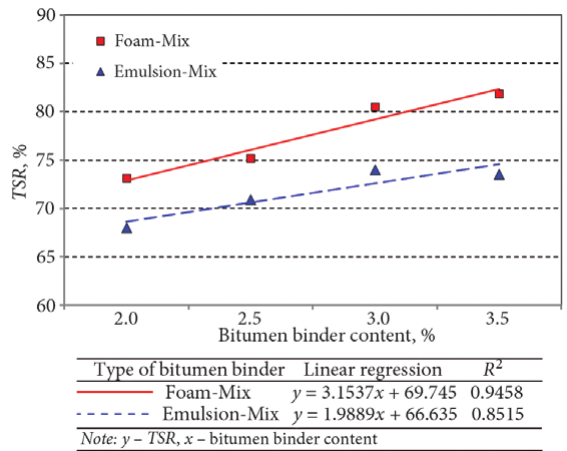
Fig. 5. Influence of the bitumen binder (foam, emulsion) content on tensile strength retained